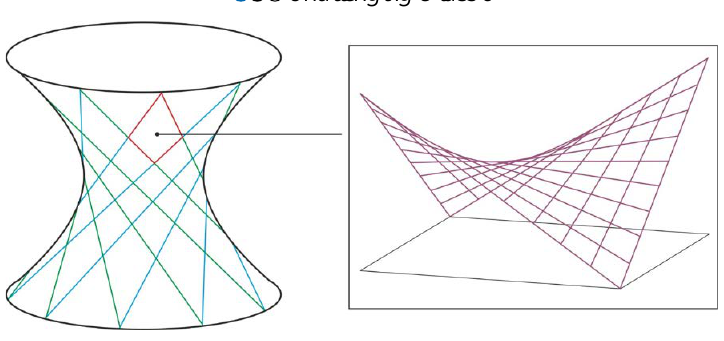
Fig. 1. A hyperbolic paraboloid shape.